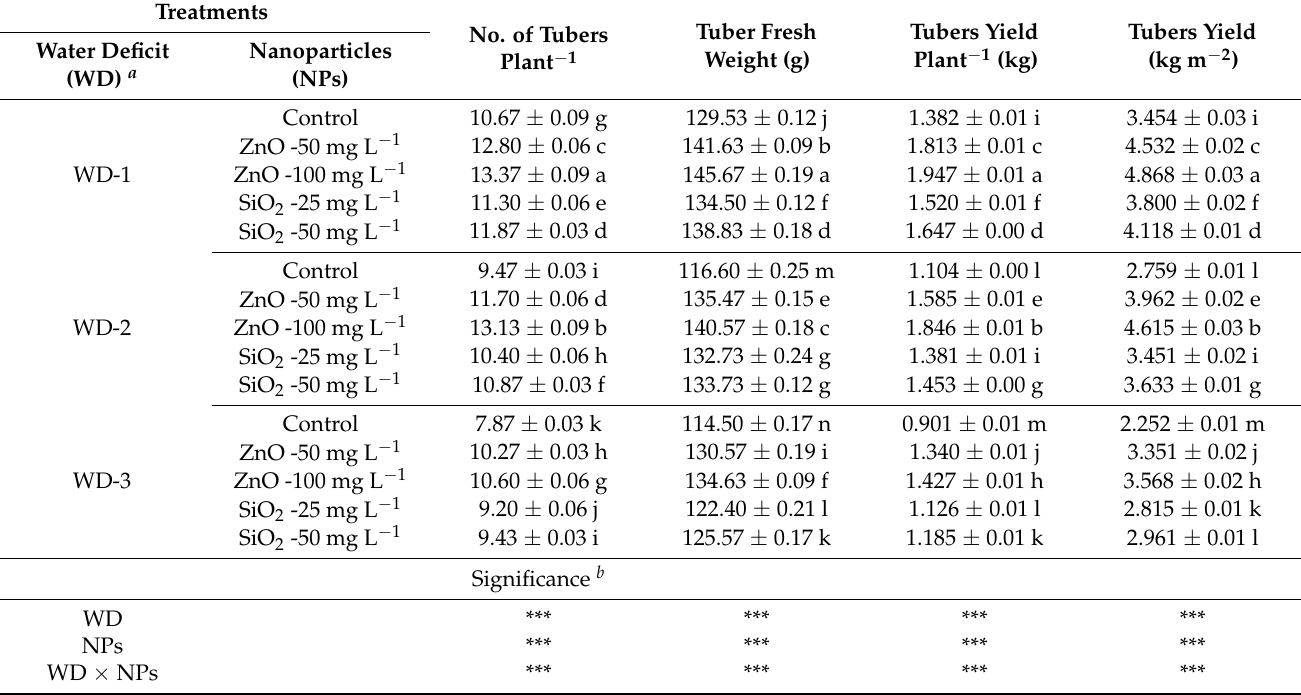
Table 2. Influence of foliar nanoparticles (NPs) on yield traits of potato grown under different water deficit conditions (irrigation